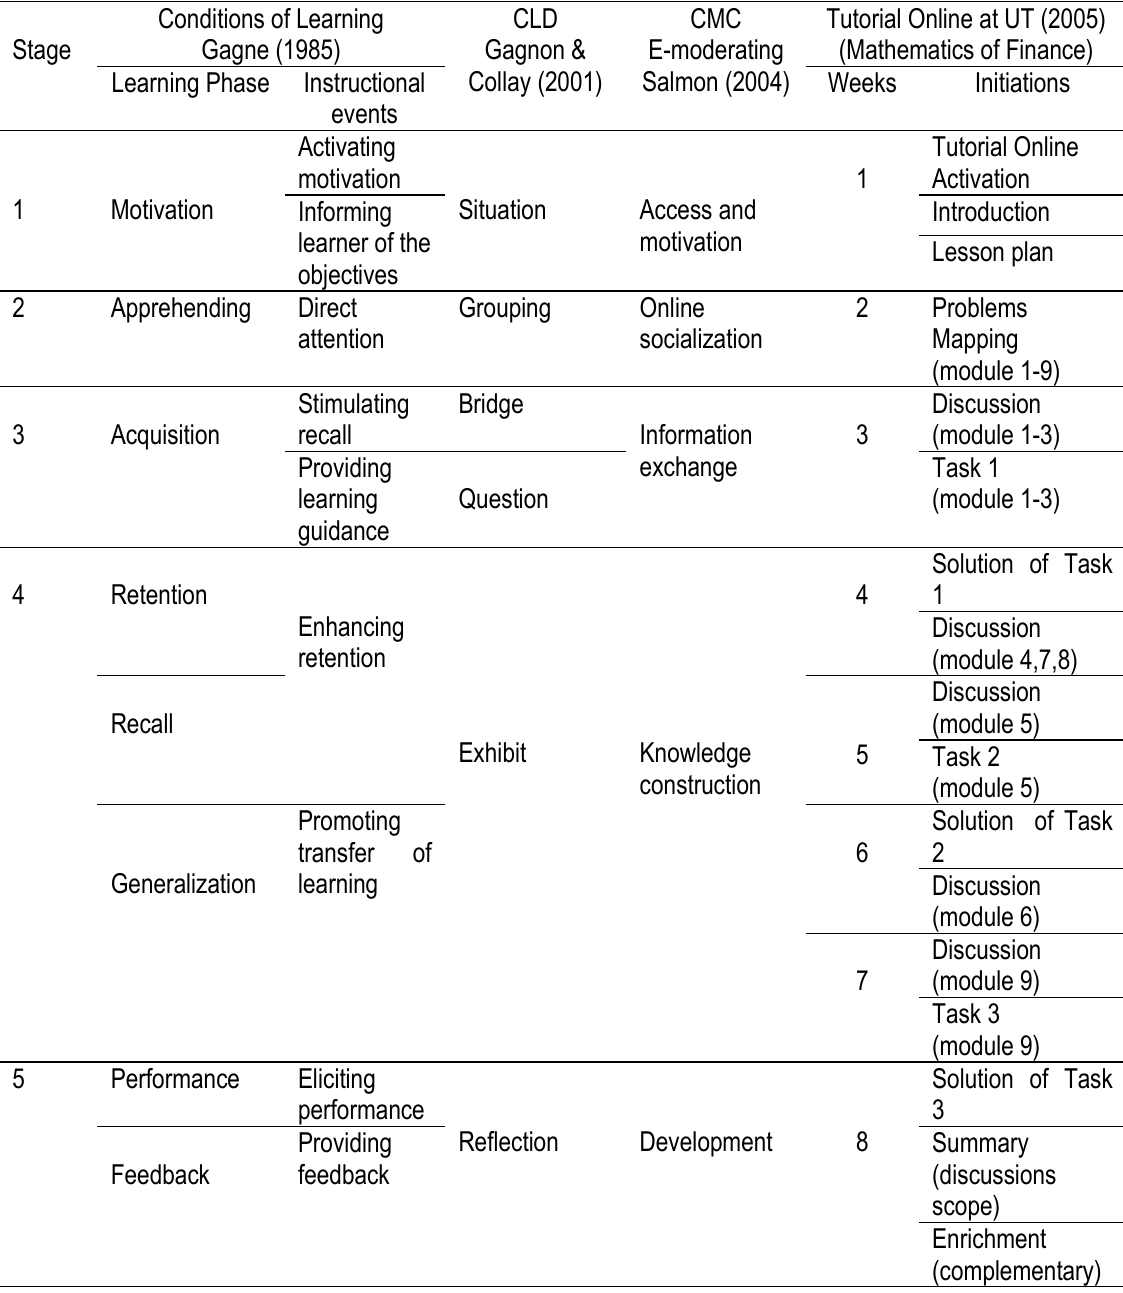
Table 1. Evaluation of Tutorial Online based on Learning Approaches